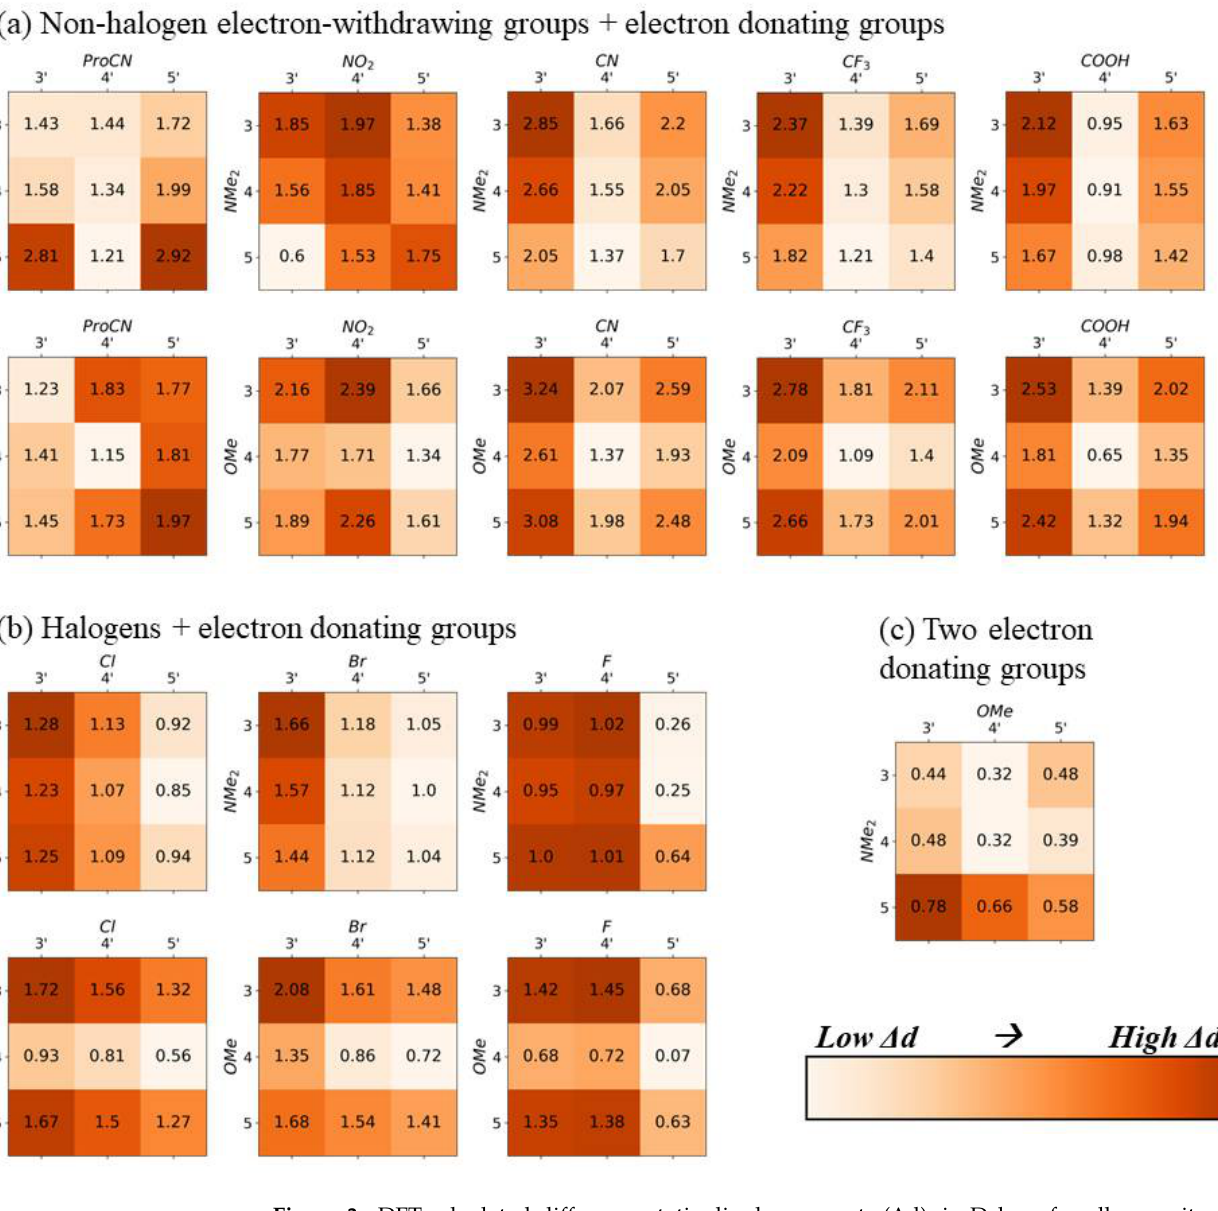
Figure 3. DFT-calculated difference static dipole moments ( ∆ d), in Debye, for all opposite-side substituent pairs. Darker orange indicates a larger static dipole difference. All calculations were per- formed with implicit solvation in water, using the integral equation formalism polarizable continuum model (IEFPCM) method (see more details in the methods section). Darker colors indicate higher values. The color range is only consistent for each substituent pair, and color-coding should not be used to compare values between pairs.